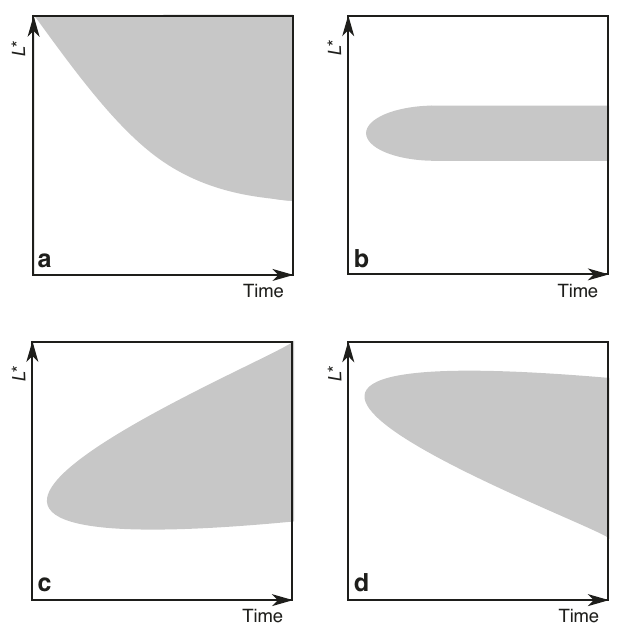
Fig. 3 An illustration of phase space density enhancements in L * and time for different acceleration mechanisms. The gray contour marks the evolving L * extent of the phase space density enhancement. Pro fi les for inward radial diffusion and local acceleration are shown in ( a ) and ( b ), respectively. The combination of local acceleration and outward radial diffusion is shown in ( c ) and local acceleration coupled with inward radial diffusion in ( d